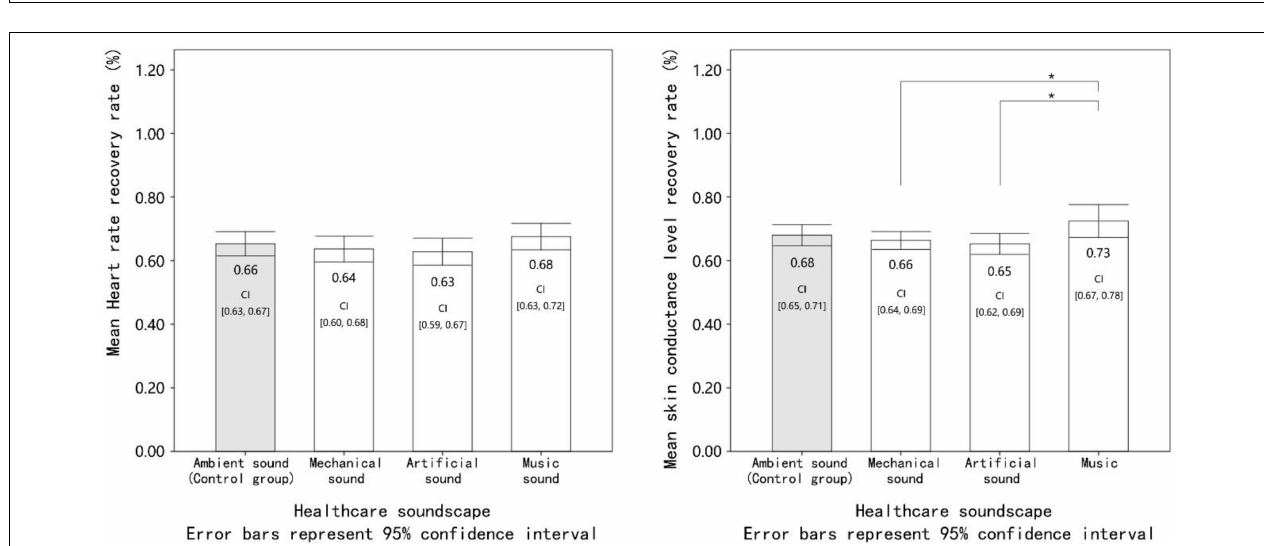
FIGURE 3 | The mean value of patients’ physiological stress recovery indicators under exposure to different healthcare soundscapes. Error bars depict 95% confidence interval. ∗ Significant at the 0.05 level. ∗∗ Significant at the 0.01 level.